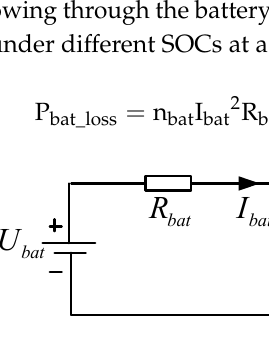
Table 1. Basic parameters of the LiFePO 4 battery cell.